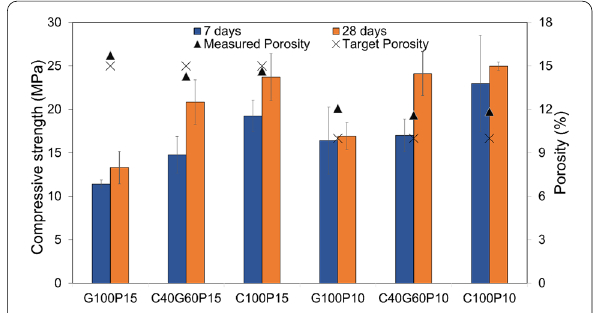
Fig. 12 Relationship between compressive strength (7 and 28 days) and porosity of the tested concrete mixtures.